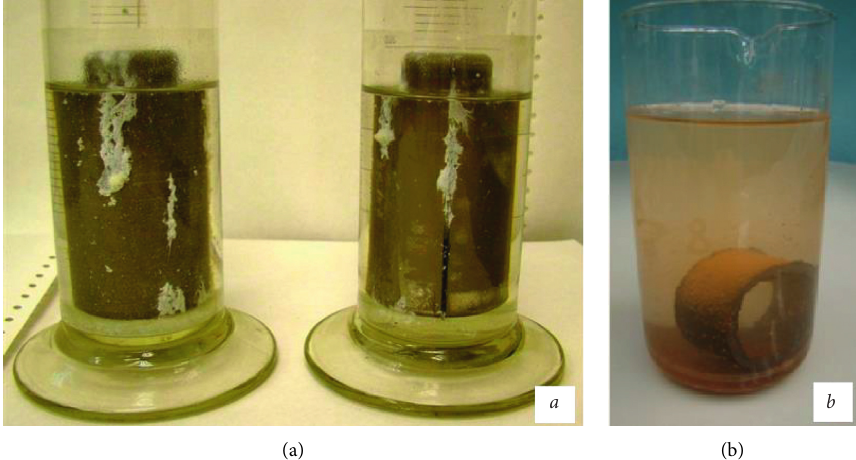
Figure 8: Appearance of aluminum (a) and iron-containing (b) elements of the reactor after corrosion tests (365 days).